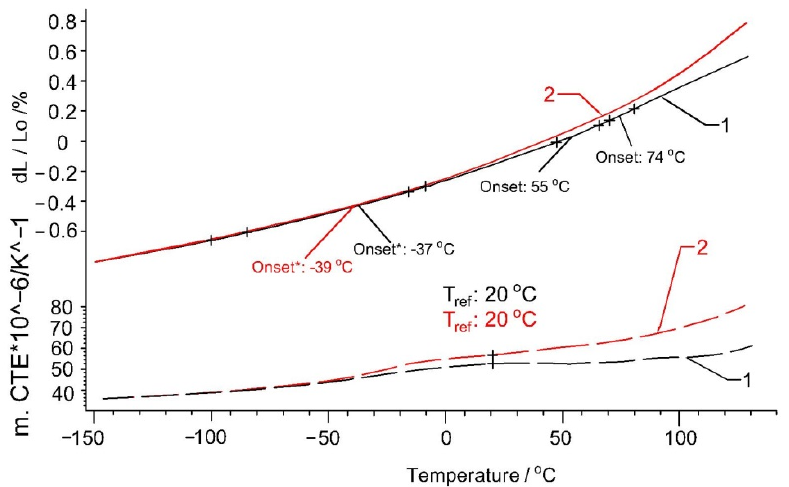
Figure 5. Thermal expansion (solid lines) and coefficient of thermal expansion of the sample Arbofill ® Fichte: 1—first heating; 2—second heating.